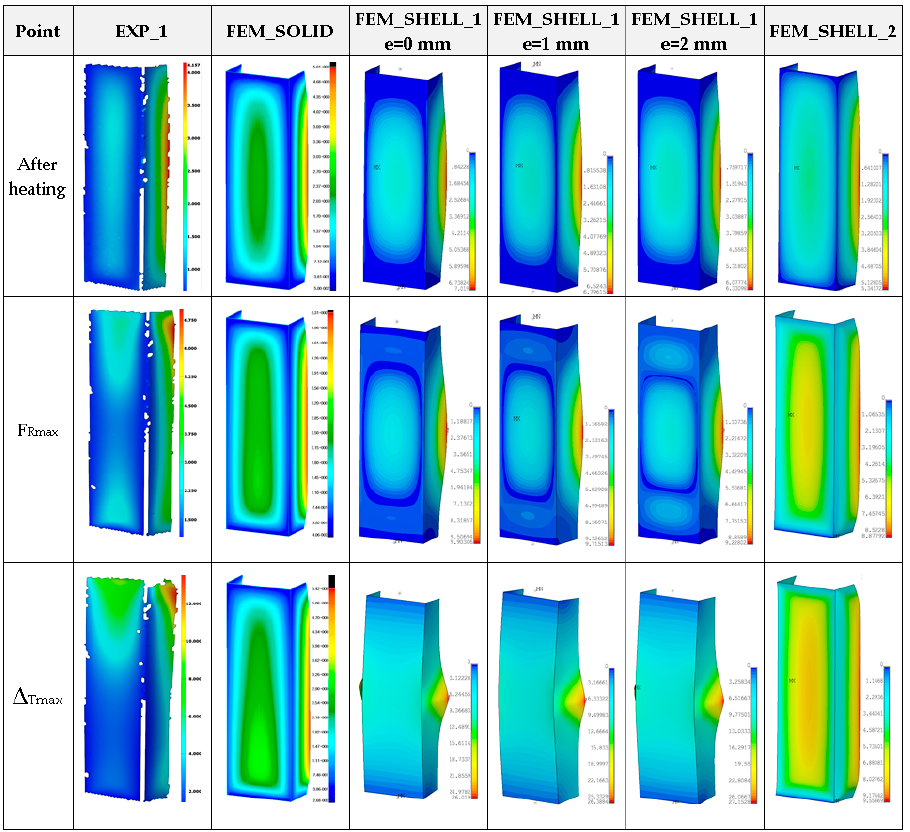
Figure 17. Deformation maps of columns at 100 °C.